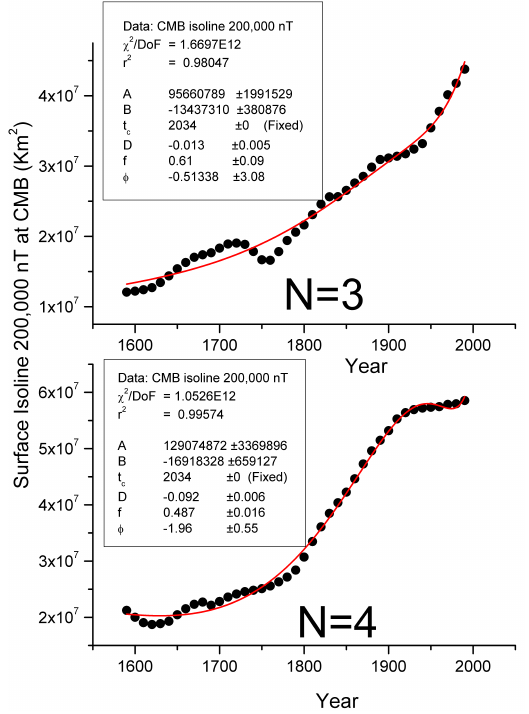
Fig. A2. Surface enclosed by the isoline 200000nT at the CMB for an expansion of GUFM1 up to the spherical harmonic degree N = 3 and N = 4. Both trends are almost monotonic and diverging in time. A log-periodic function with critical (a priori fixed) time of 2034yr is a reasonable fit for both